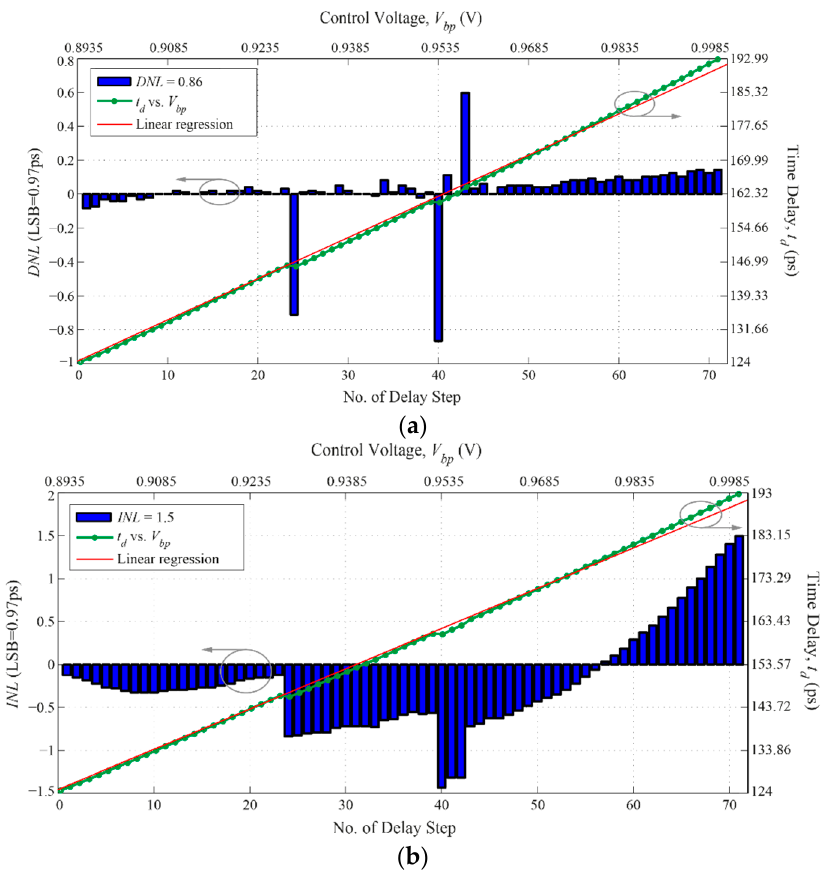
Figure 7. DLL’s total time delay and control voltage ranges with respect to the delay steps linearity: ( a ) DNL ; and ( b ) INL .